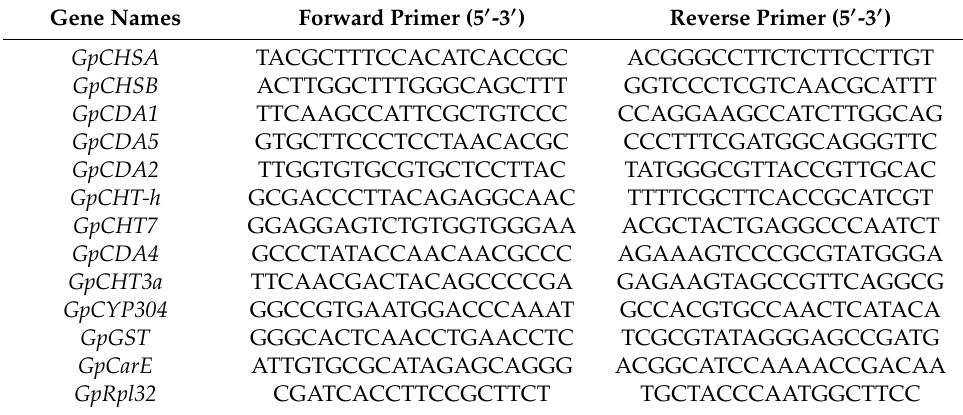
Table 4. Primers used in quantitative reverse transcription PCR